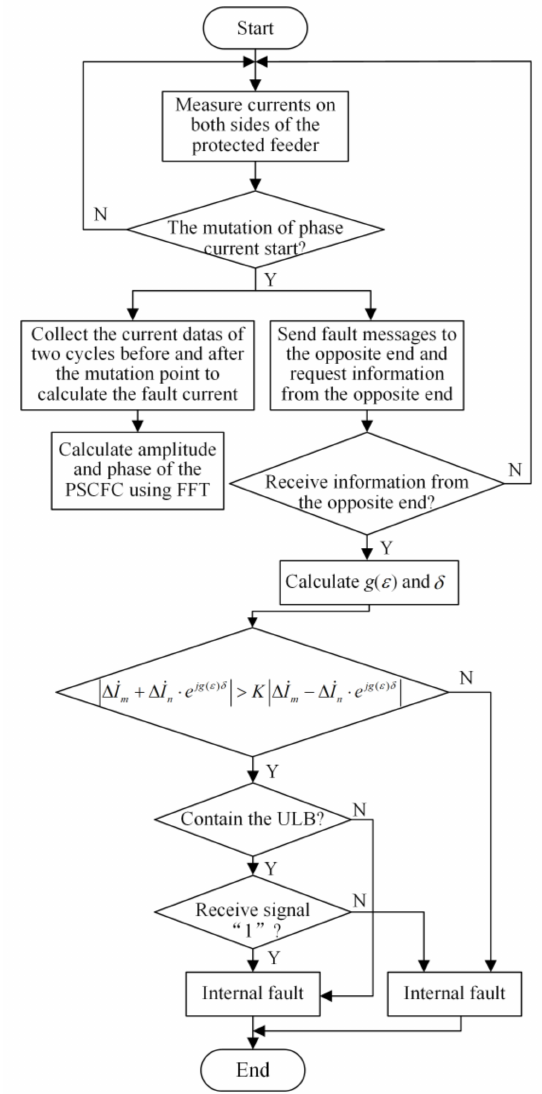
Figure 13. Flowchart of the proposed protection